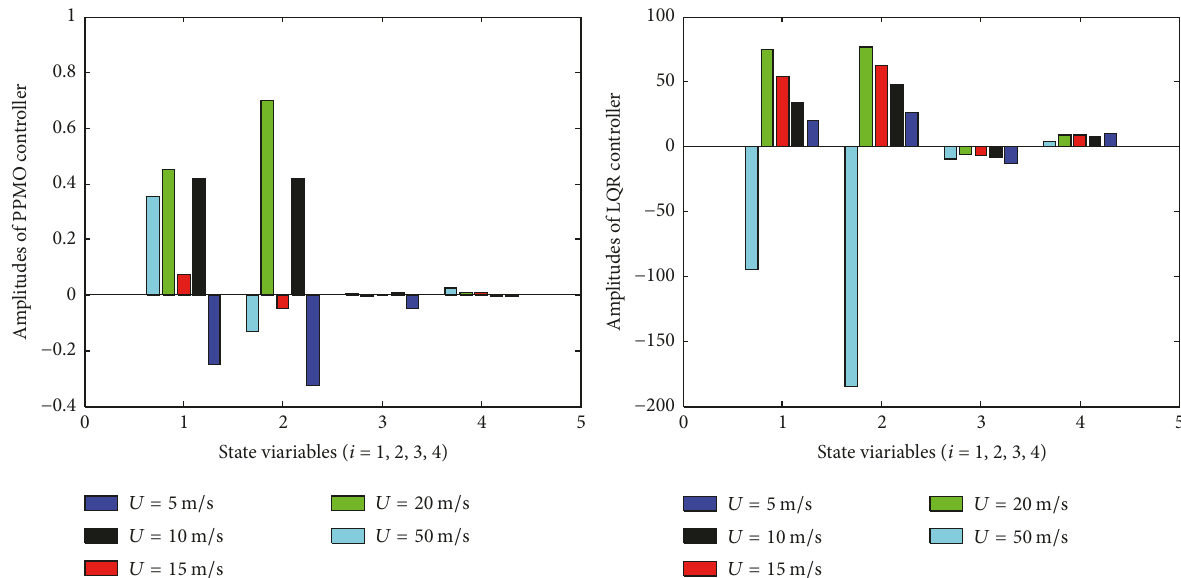
Figure 8: Amplitudes of PPMO controller and LQR controller versus different state variables.